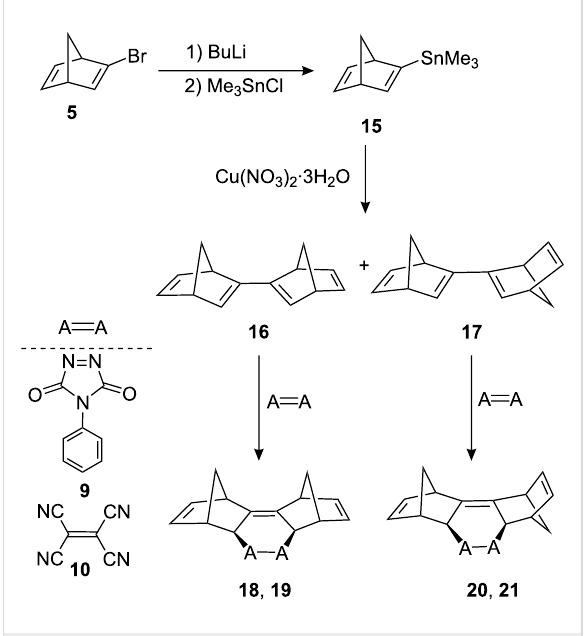
Scheme 3: Synthesis and Diels–Alder cycloaddition reactions of dimers 16 and 17 .